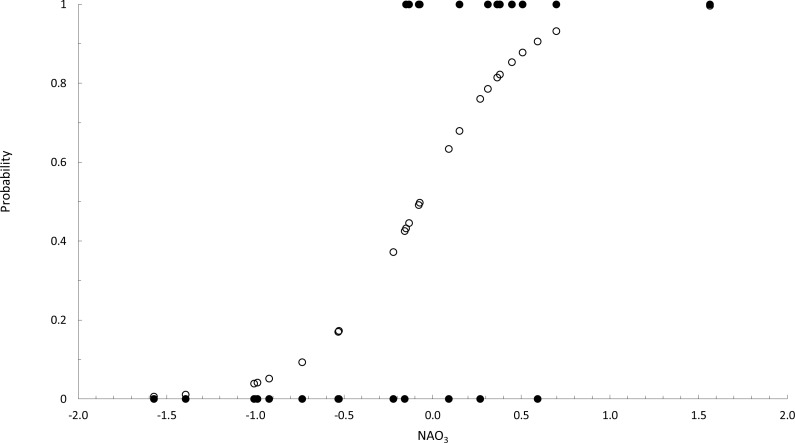
Binary logistic regression of occurence of Fucus guiryi as a function of NAO3.Probability (white circles) and presence (1)/absence (0) (black circles) of Fucus guiryi at Punta de Calaburras from 1990 to 2015, as a function of the North Atlantic Oscillation averaged for the months between April and June (NAO3), as an explanatory independent environmental variable.